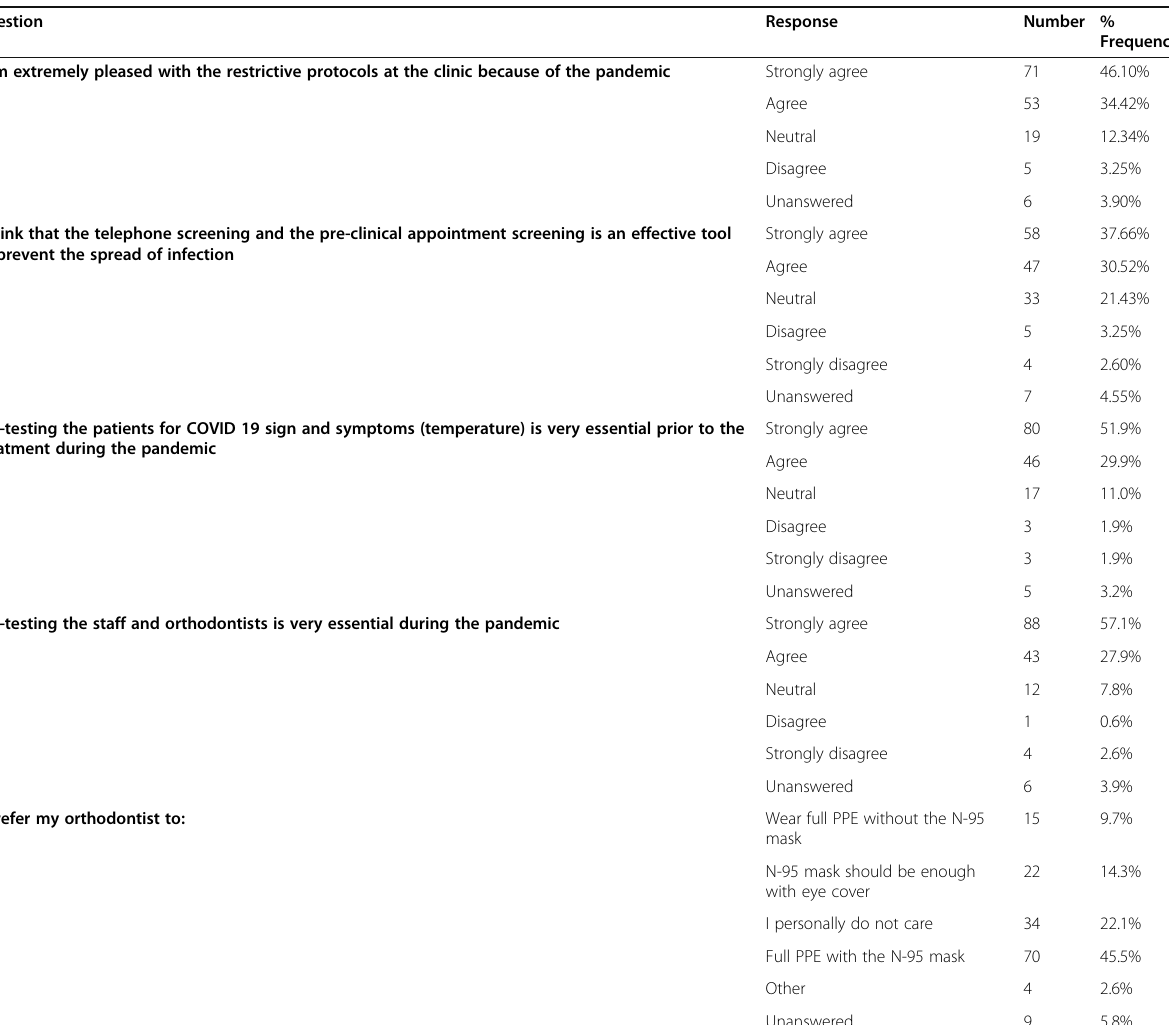
Table 5 Section 5: